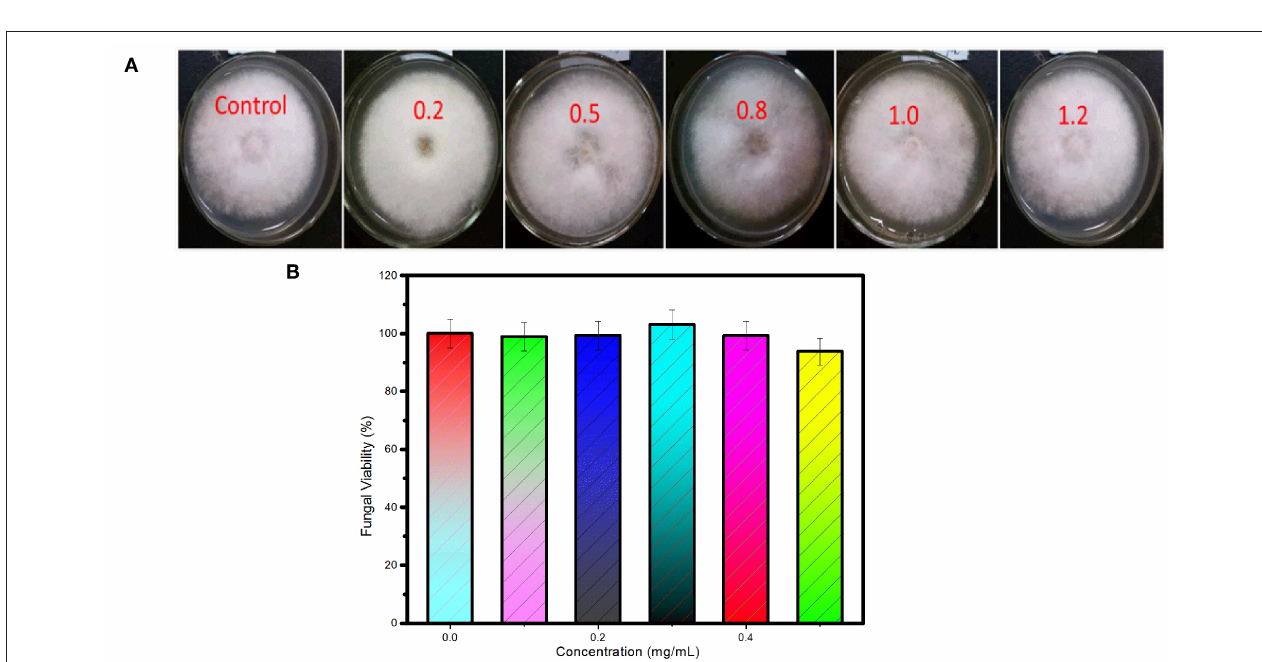
FIGURE 5 | Cytotoxicity of the as-synthesized carbon dots to C. gloeosporioides . (A) Photos and (B) viability of the fungus growing on the medium containing the as-synthesized carbon dots at the concentrations of 0.2, 0.5, 0.8, 1.0, 1.2 mg/ml, respectively.